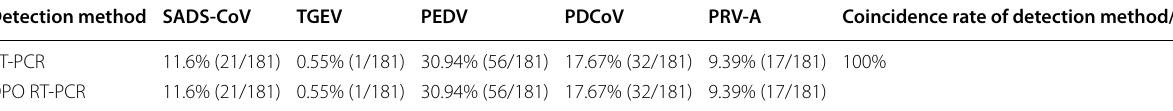
Table 2 Clinical application of the conventional RT-PCR and DPO system-based multiplex RT-PCR detection method Detection method